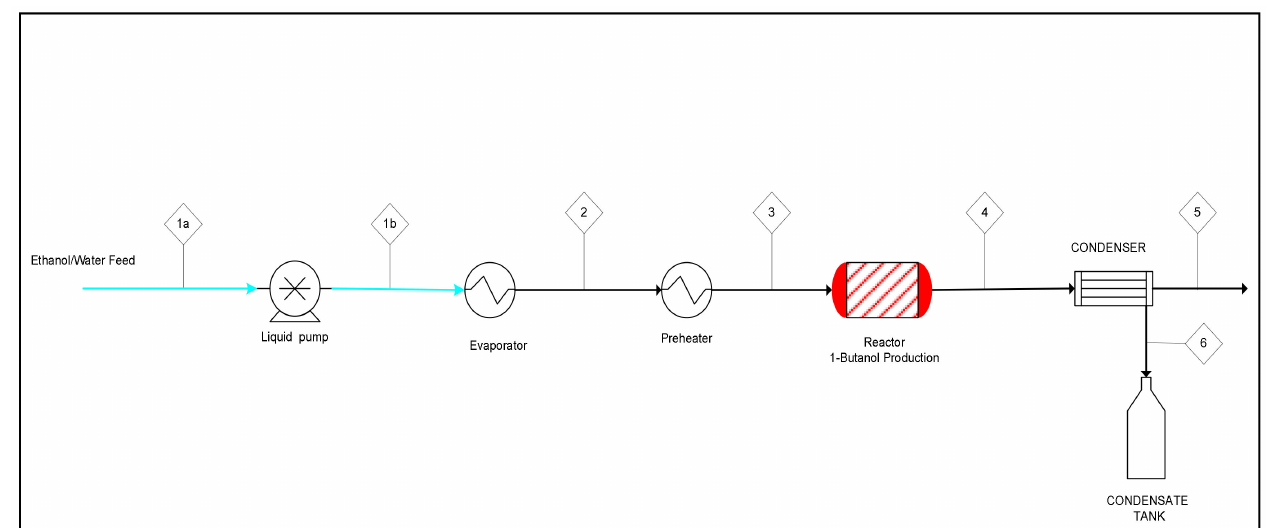
Figure 18. Schematic description of the mini-pilot unit. Streams: 1a, 1b—liquid hydrous ethanol; 2—evaporated hydrous ethanol; 3—preheated hydrous ethanol (reactor inlet); 4—products streams (reactor outlet); 5—gaseous products; 6— condensed